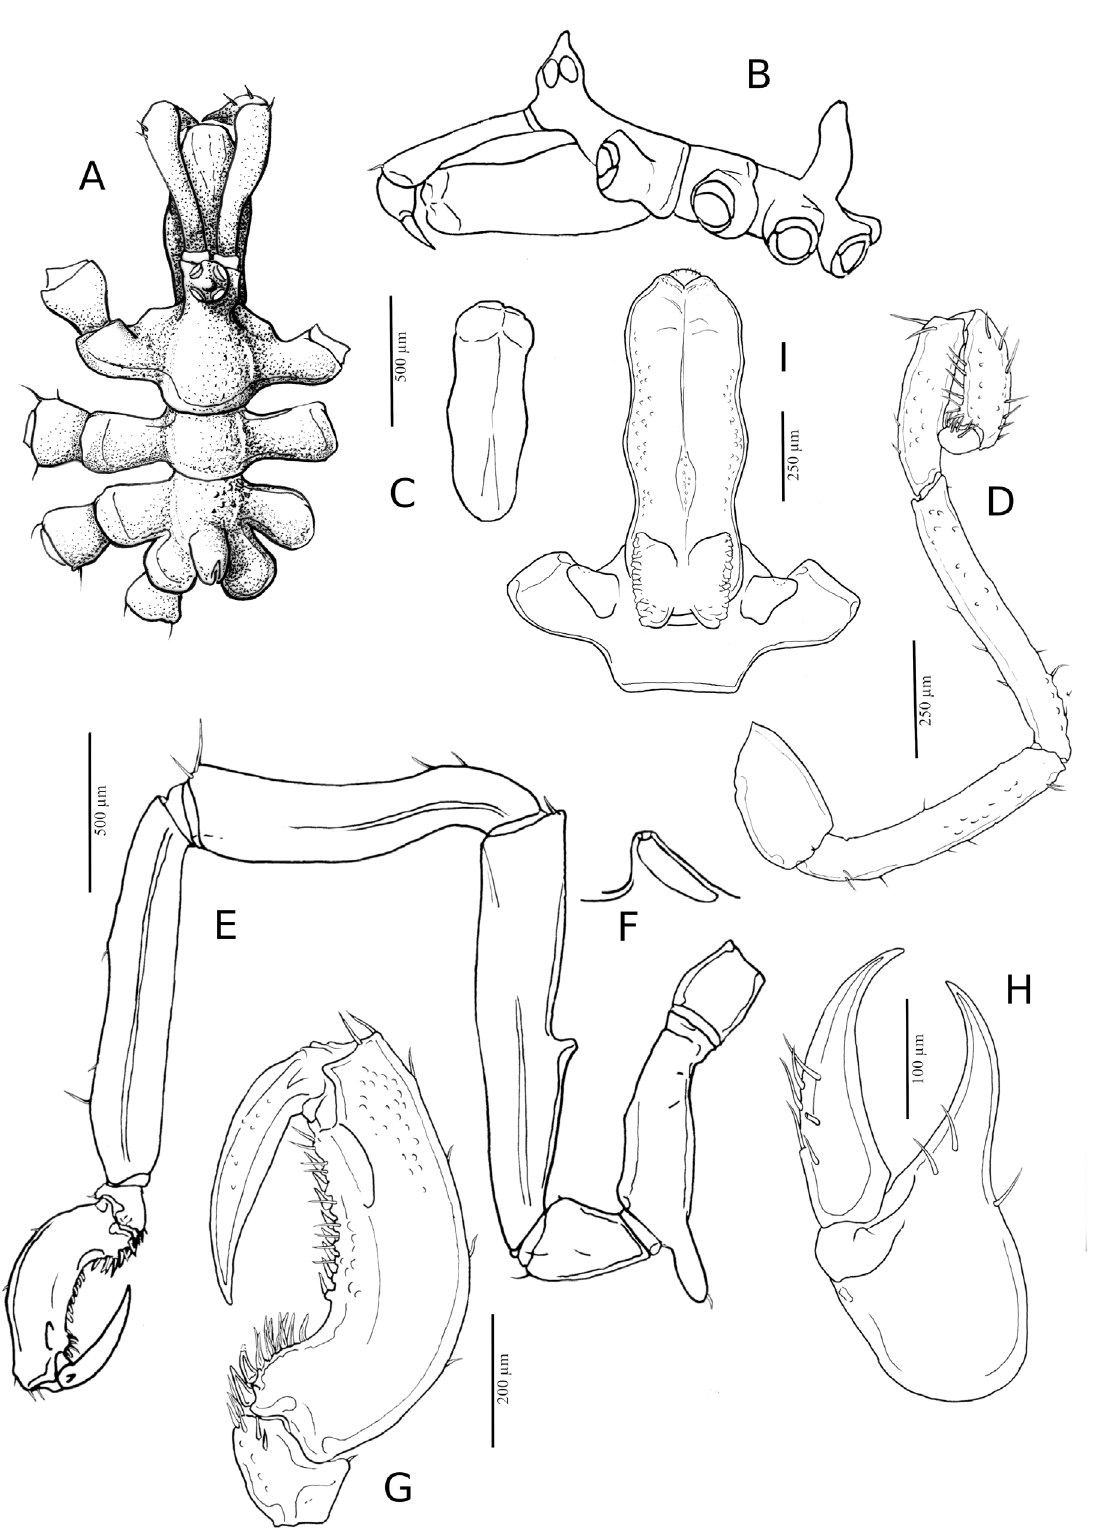
Fig. 21. Anoplodactylus cf. californicus Hall, 1912. A–H . ♂, MNHN-IU-2016-855. I . ♀, MNHN- IU-2016-810. A . Body, dorsal view. B . Body, lateral view (same scale as A). C . Proboscis, ventral view (same scale as A). D . Oviger. E . Third leg. F . Cement gland tube. G . Propodus of third leg. H . Chela. I . Cephalon and proboscis, ventral